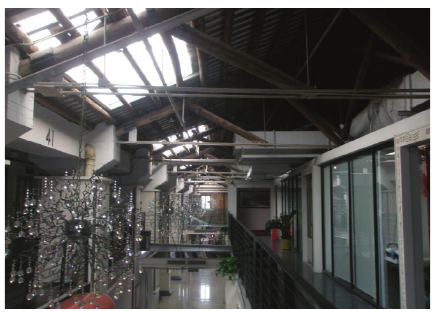
Figure 6: Interior